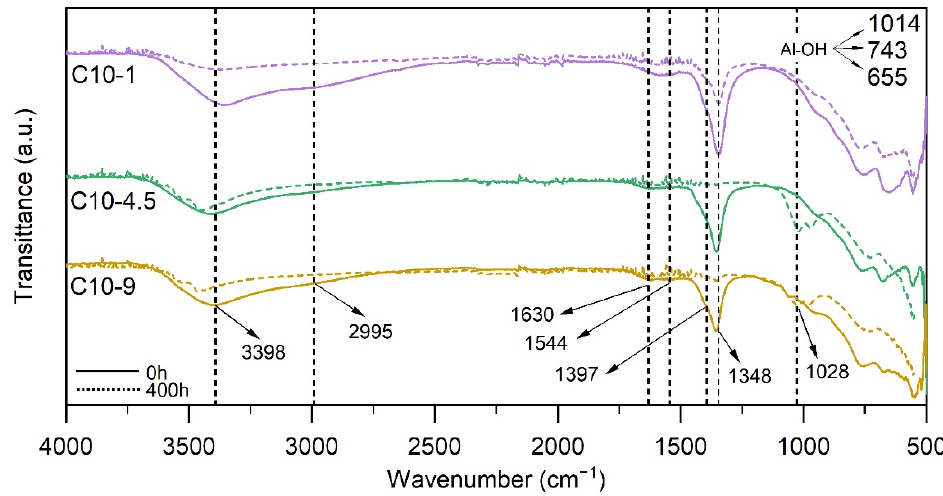
Figure 3. IR spectra from 500 cm − 1 to 4000 cm − 1 for C10 series obtained in ATR mode .